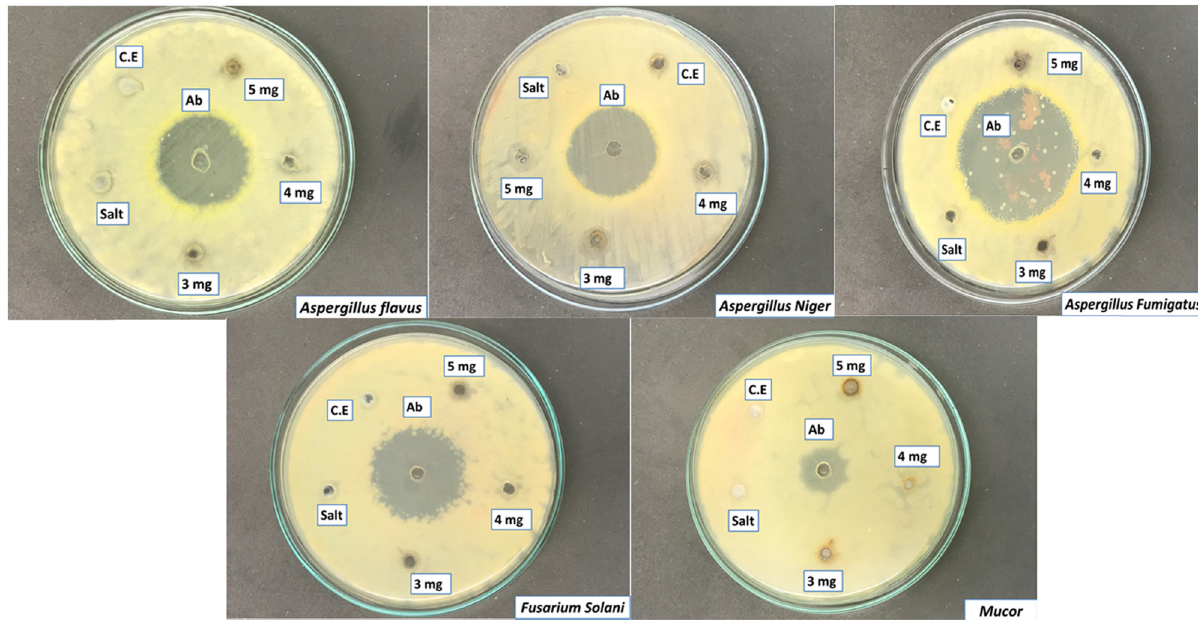
Figure 10: Antifungal activity of Ag - NPs against fi ve di ff erent fungal strains at di ff erent concentrations ( 5, 4, and 3 mg · mL − 1 ) ; Ab – antibiotics, CE – callus